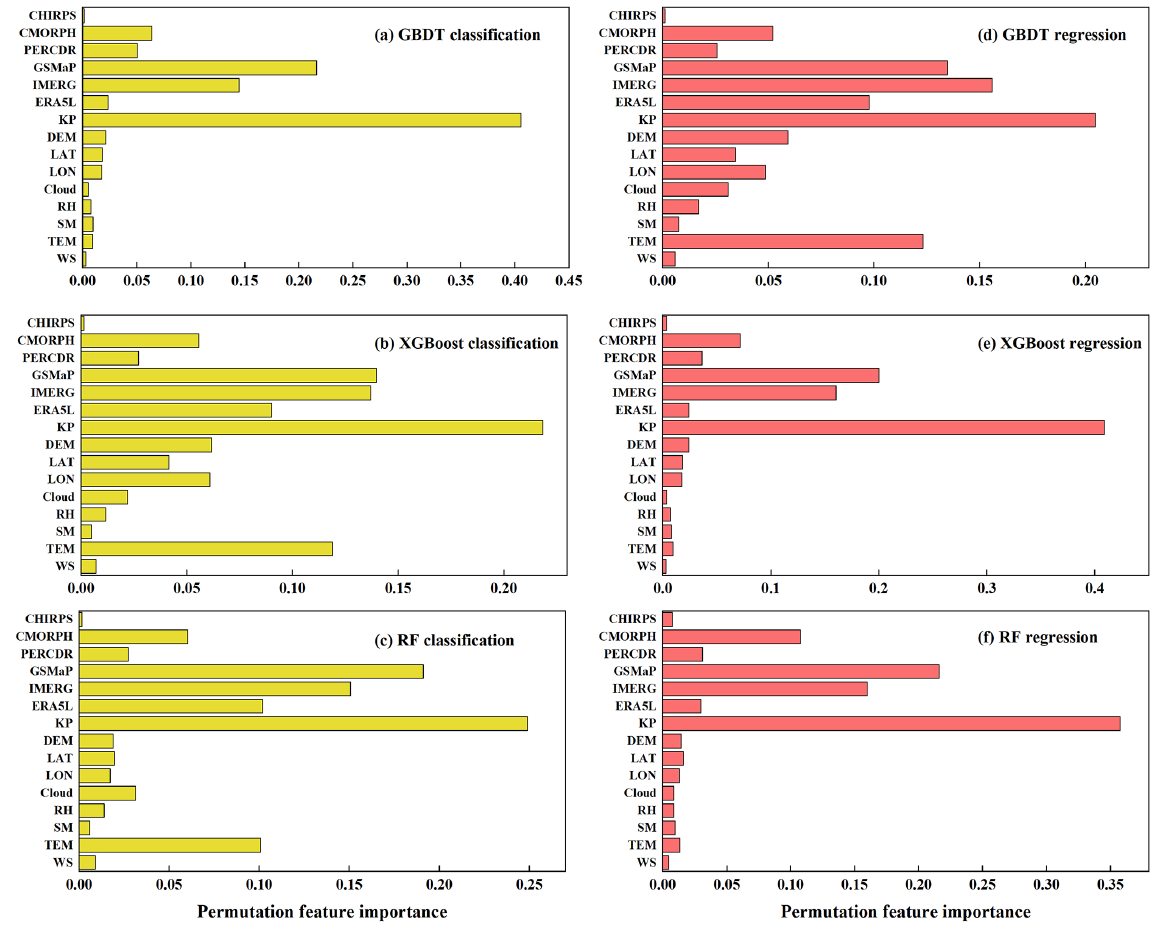
Figure 9. Permutation feature importance of three (GBDT, XGBoost, and RF) classification models (a–c) and three regression model (d–f) in the warm season (LAT is latitude, LON is longitude, RH is relative humidity, SM is soil moisture, TEM is temperature, and WS is wind